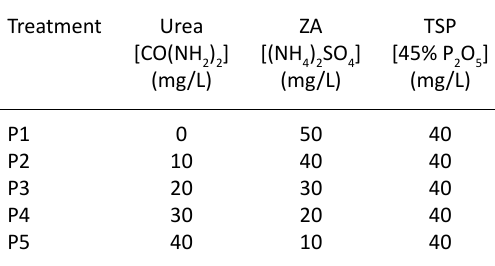
Table 1. Variations in commercial fertilizers used in